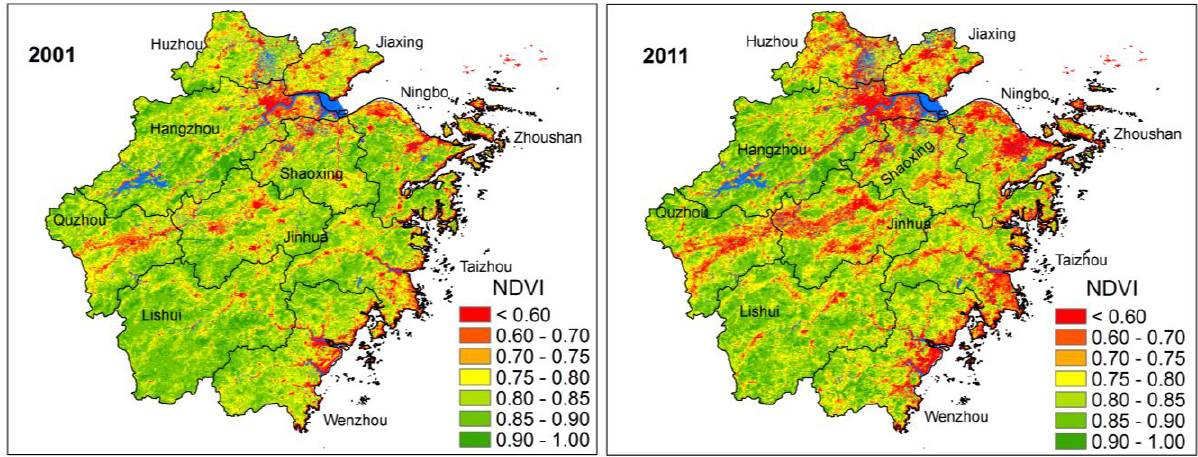
Figure 5. Annual maximum NDVI for 2001 and